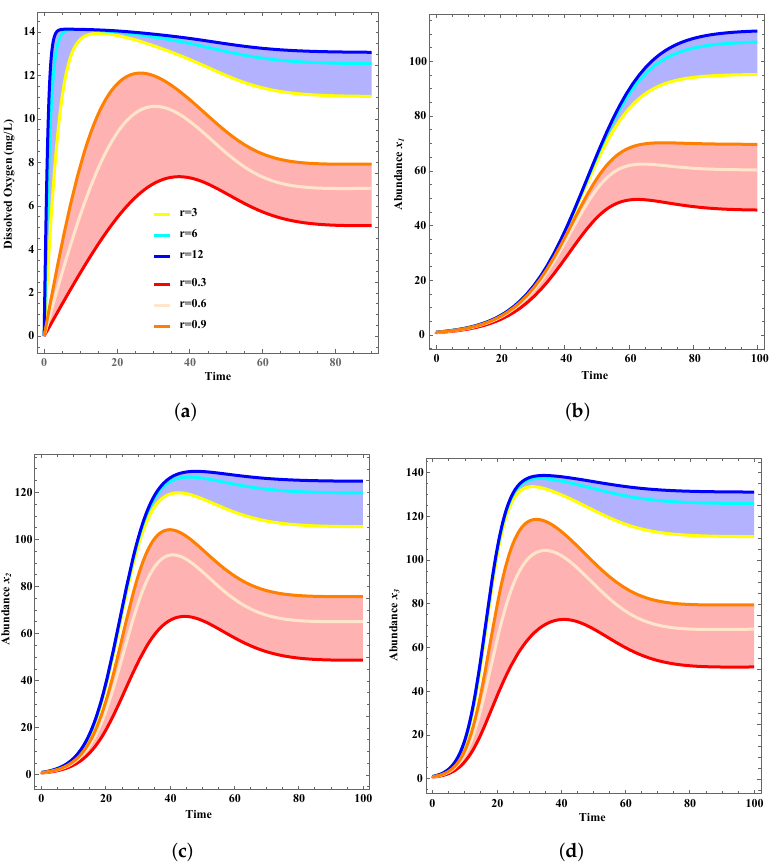
Figure 2. Influence of oxygenation/aeration rate r on AM population densities. ( a ) Variation of DO through time for different values of r. The population fluctuations of the different classes of AMs are shown in ( b ), ( c ), and ( d ) for x 1 , x 2 , and x 3 , respectively. Note that, in all cases, if r is smaller, then AM reproduction is smaller and slower than when r is larger.